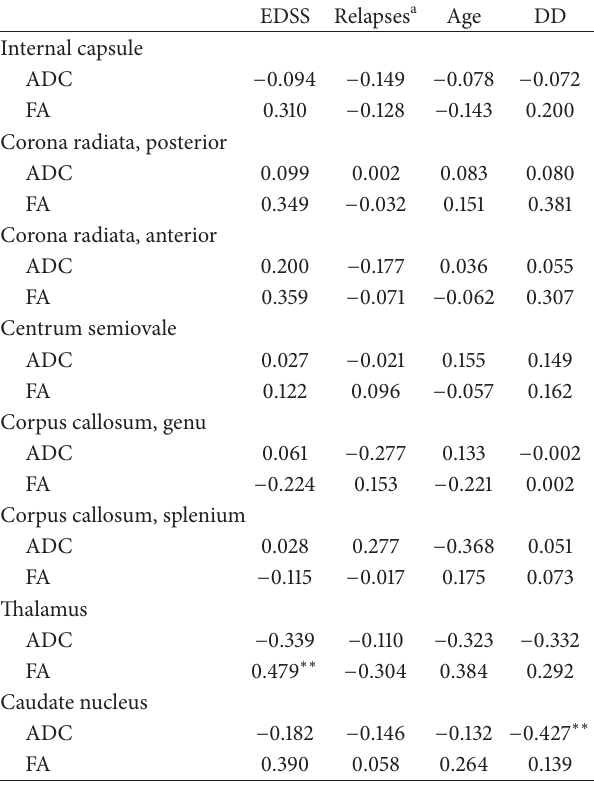
Table 2: Clinicoradiological correlations between DTI indices and clinical findings in RRMS patients ( 𝑛 = 35